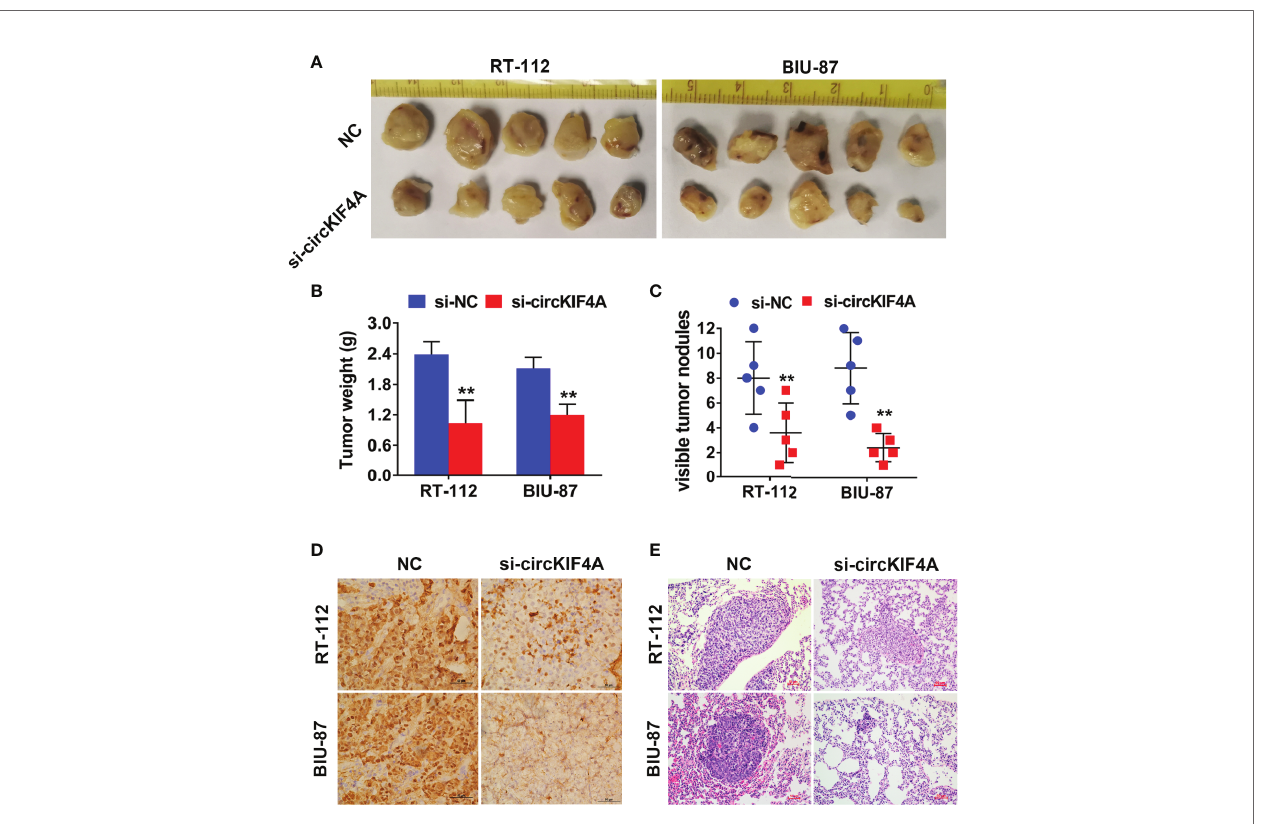
FIGURE 2 | Downregulation of circKIF4A suppresses the proliferation and metastasis of bladder cancer in vivo. (A) A mouse xenograft model was established using RT-112 and BIU-87 cell lines. (B) Tumor volumes were weighed. (C) The number of metastatic sites in the lung was counted and recorded. (D) Xenograft tumors were stained with Ki-67 antibody for immunohistochemistry analysis, and representative images are presented. (E) HE-stained sections of lung metastases were imaged under a microscope. **P < 0.01.